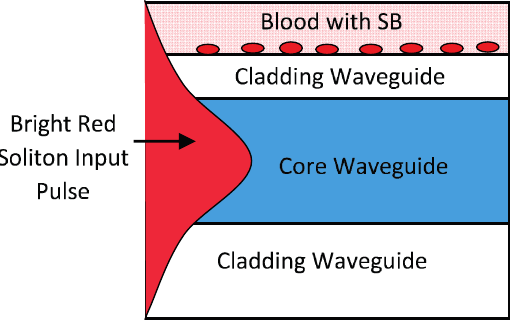
Figure 7. Schematics diagram of the bright red soliton pulse